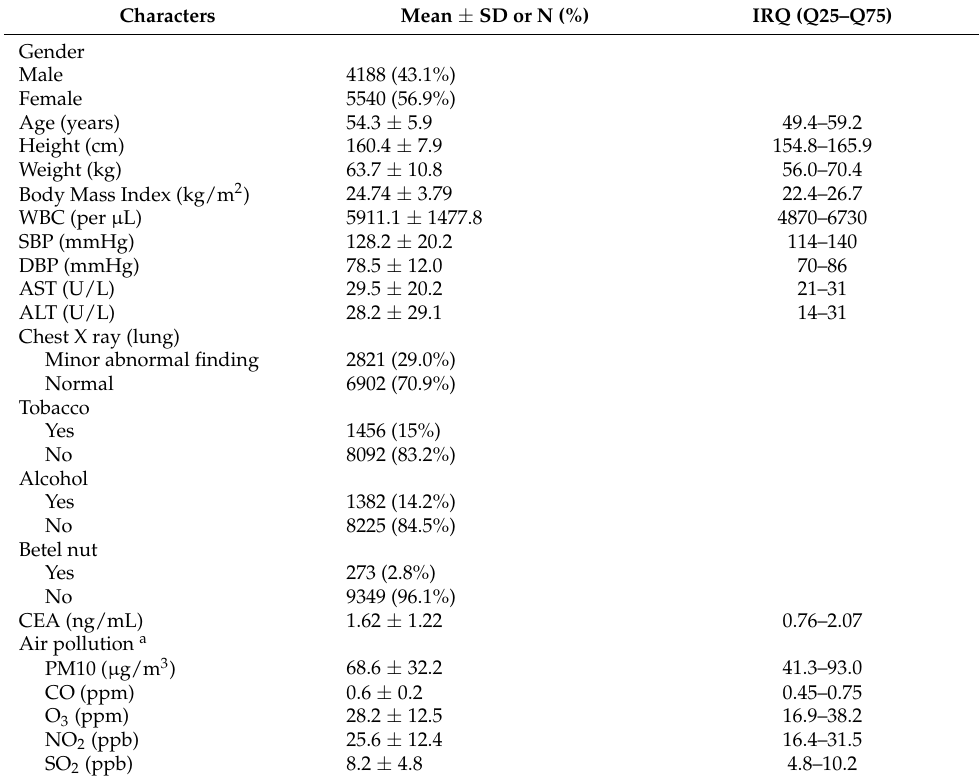
Table 1. Demographic characteristics of participants in the